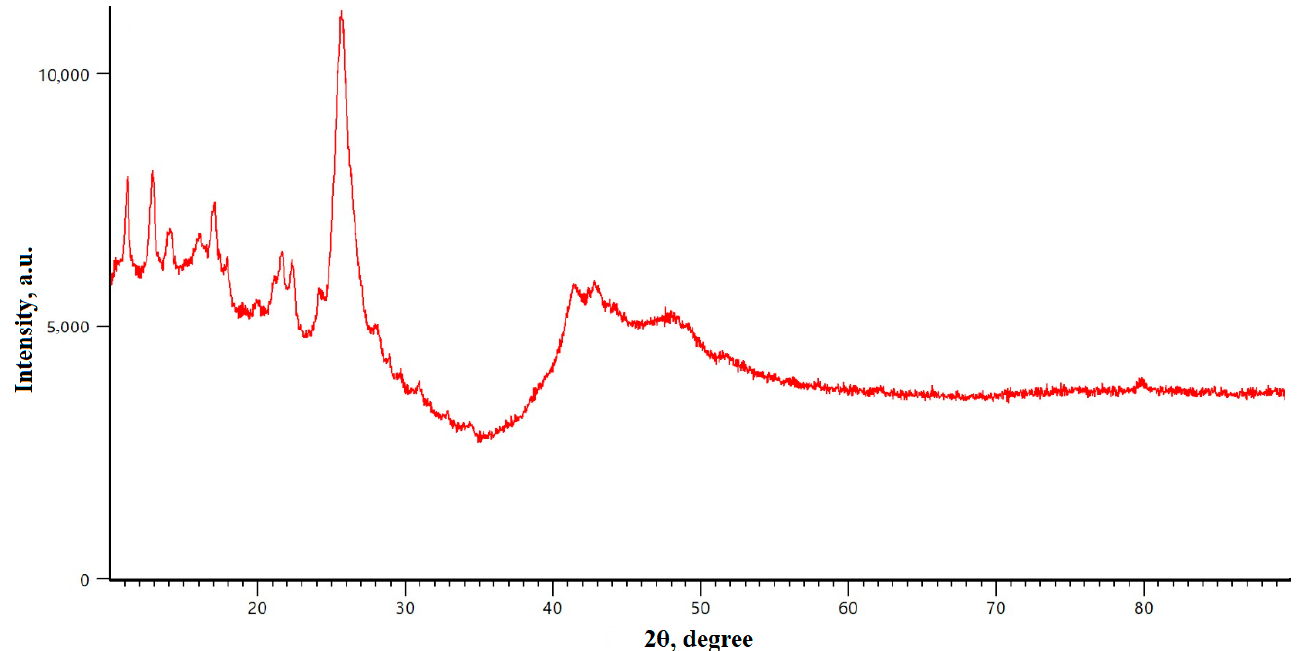
Figure 7. XRD of polymethylene blue synthesized by chemical oxidative polymerization of methylene blue.